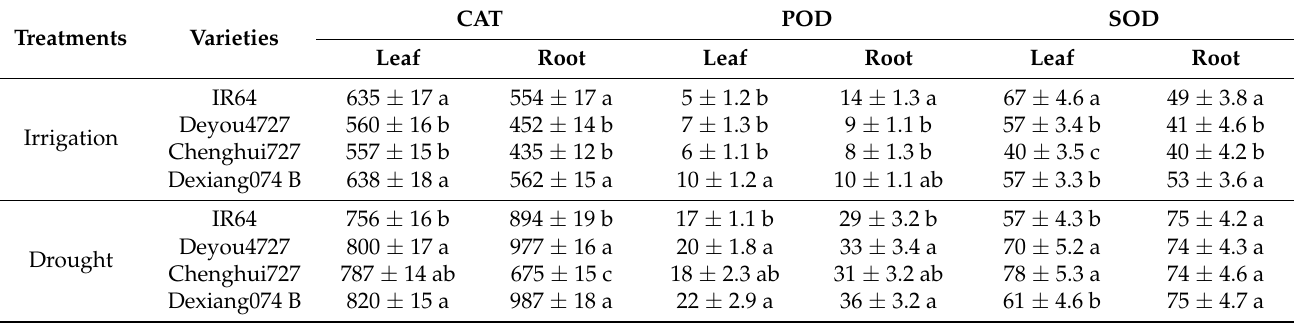
Table 2. The effects of drought stress on antioxidant enzyme activity in different rice